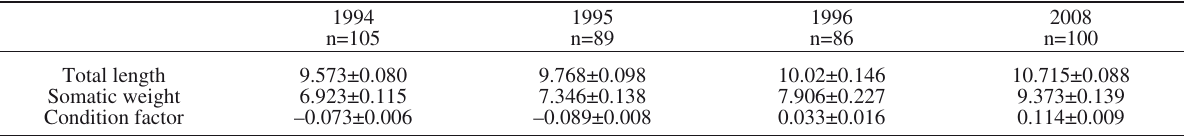
Fig . 5. – Relationship between batch fecundity and GSI (A) and somatic weight (B) in the common kilka (n=25). Table 3. – The average of total weight, somatic weight and residual, as a size-independent measure of somatic condition, ± SE of female common